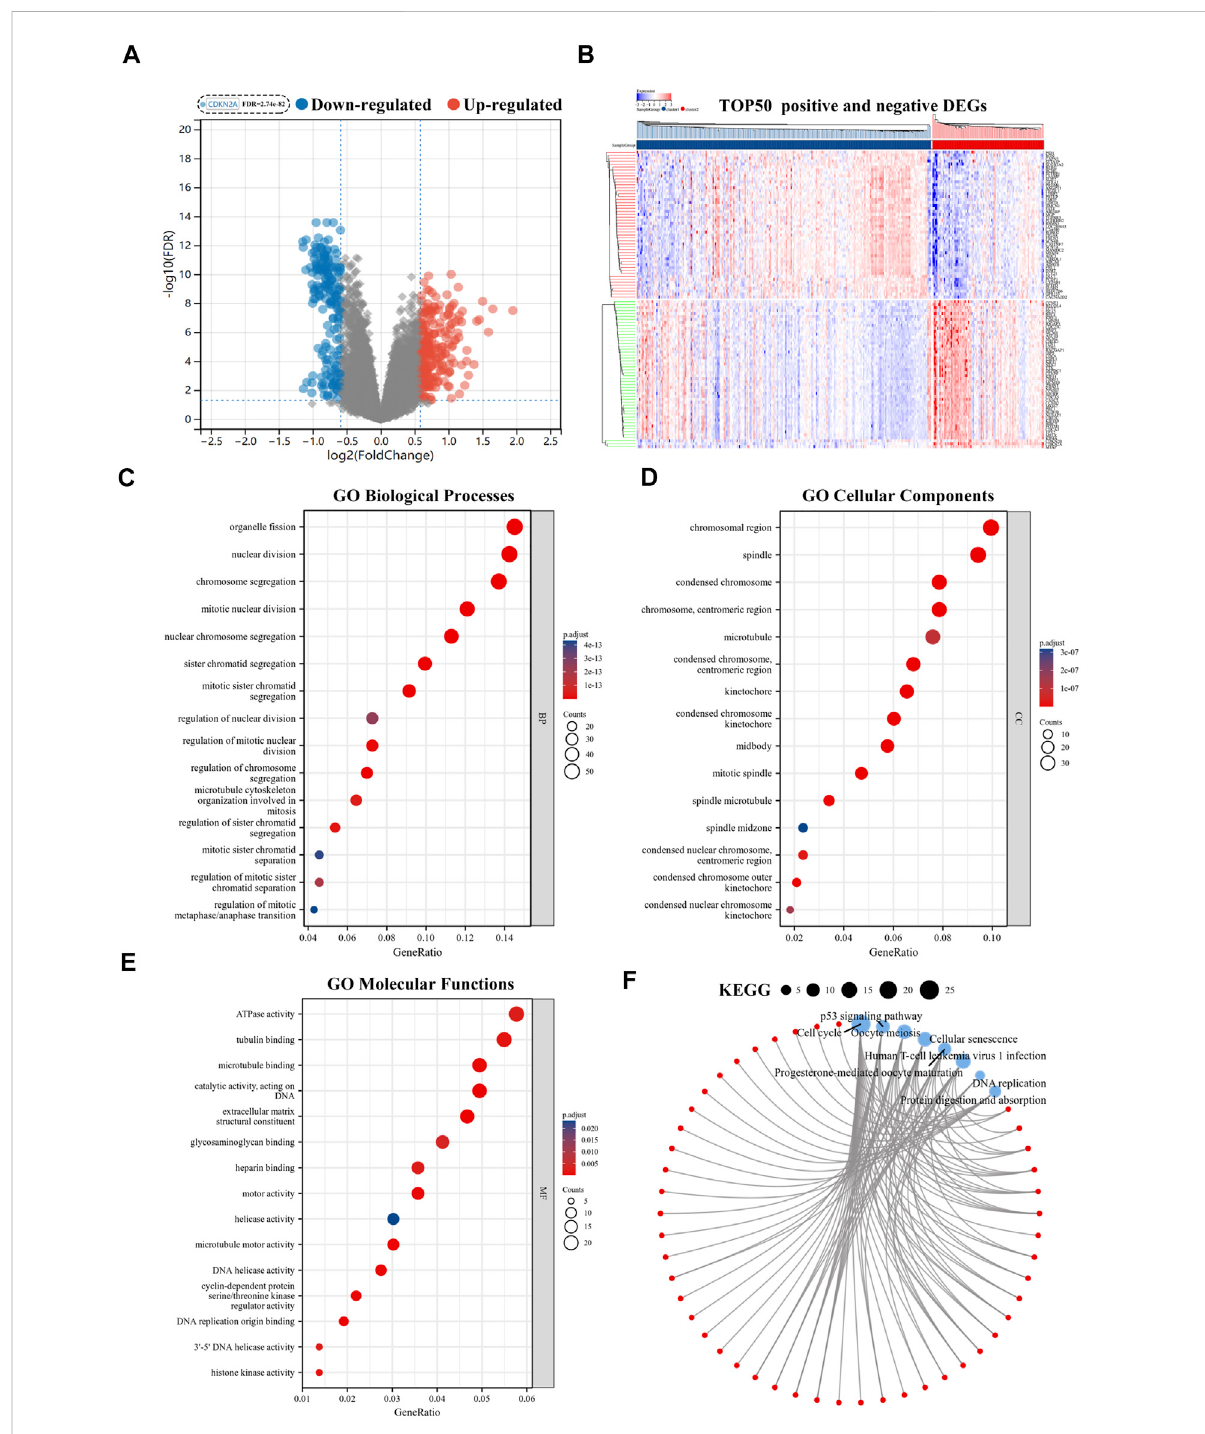
FIGURE 2 Functional enrichment analyses of CR-DEGs. (A) Volcano plot for the CR-DEGs with statistical signi fi cance (the green dots represented down- regulatedgenes,andthereddotsrepresentedup-regulatedgenes); (B) Theheatmapshowedtheexpressionoftop50up-anddown-regulatedCR- DEGs; (C – E) GO analysis of CR-DEGs (|Fold Change| > 1.5 and FDR < 0.05); (F) KEGG analysis of CR-DEGs (|Fold Change| > 1.5 and FDR < 0.05). CR- DEGs: cuproptosis-related differentially expressed genes; GO: Gene Ontology; KEGG: Kyoto Encyclopedia of Genes and